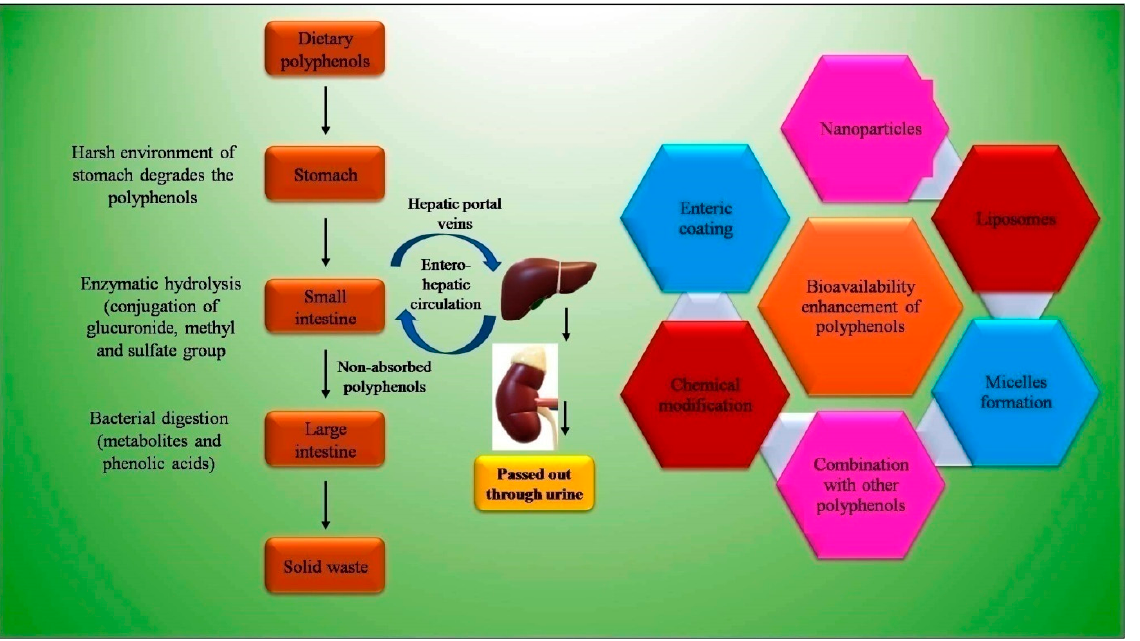
Figure 4. Bioavailability issues of polyphenols and strategies to overcome it.